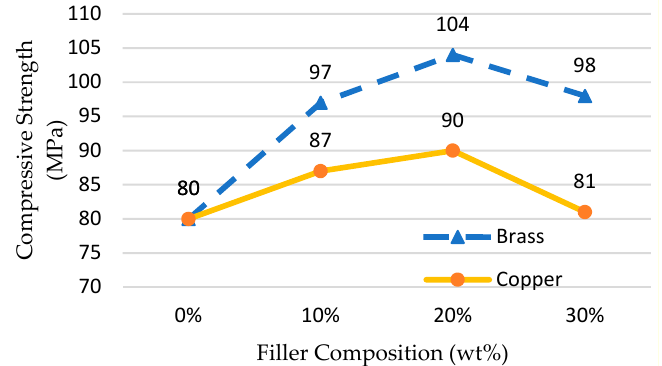
Figure 8. Effects of fillers on compressive